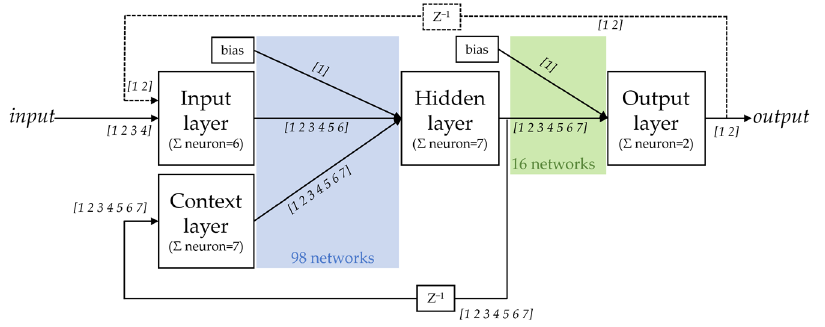
Figure 1. Modified Elman neural network.